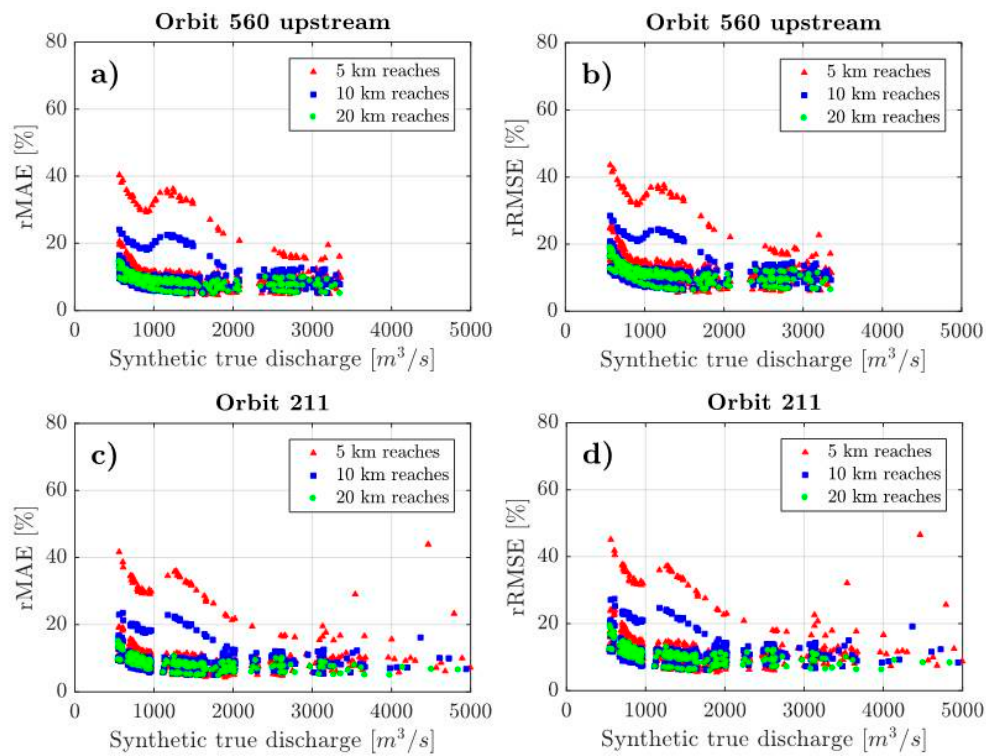
Figure 4. Scatter plot of synthetic (reproduced by the hydraulic model) and estimated (SWOT-based) discharges for each river stretch ( Δ x = 5, 10, 20 km) and for all satellite overpasses during the study period (2008–2010). The figure also reports the coefficient of determination (R 2 ) between the discharge series for different Δ x .